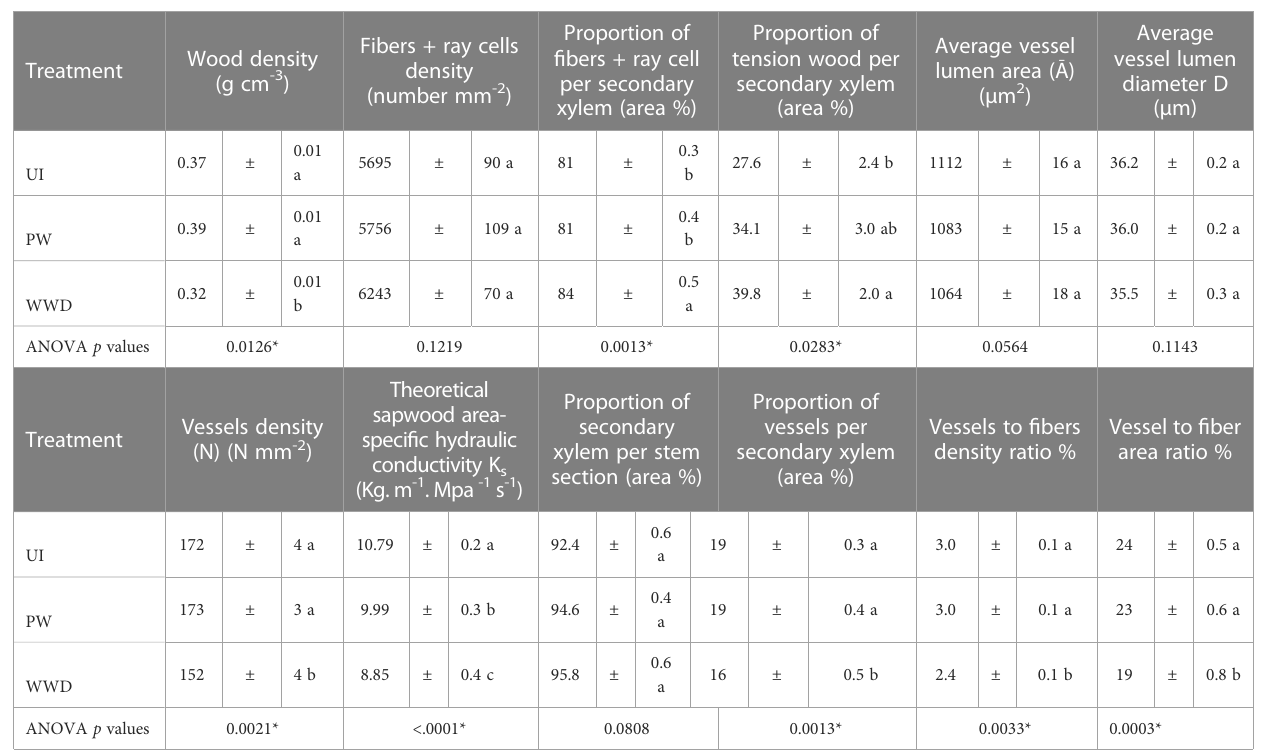
The results represent the average values (mean ± standard error) for each irrigation treatment. For each variable, different letters indicate signi fi cant differences according to HSD-Tukey test for the irrigation treatments (p ≤ 0.05).